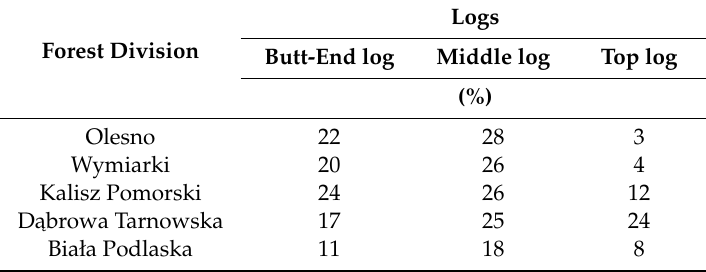
TOTAL 0 Table 18. The percentage of bark pocket and resin pitch as a factor a ff ecting the quality class of sawn timber in the longitudinal section of long logs for the various forest divisions. Logs Forest Division Butt-End log Middle log Top log